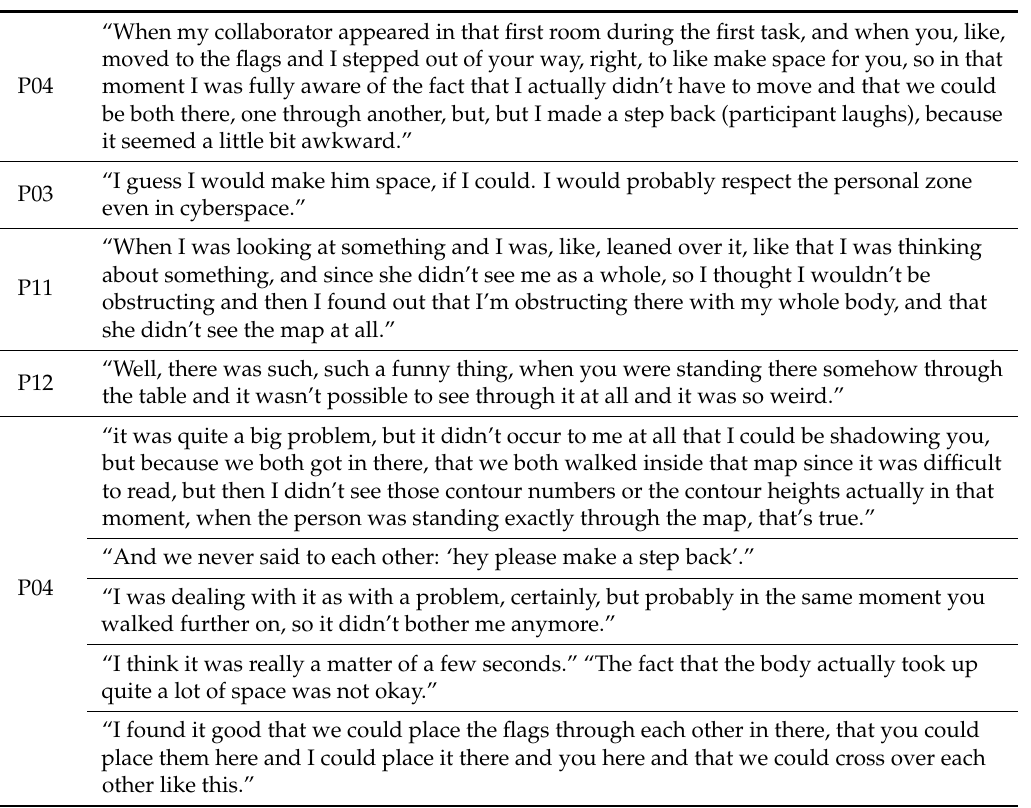
Table 7. Verbatim excerpts of statements by participants: Having an intangible